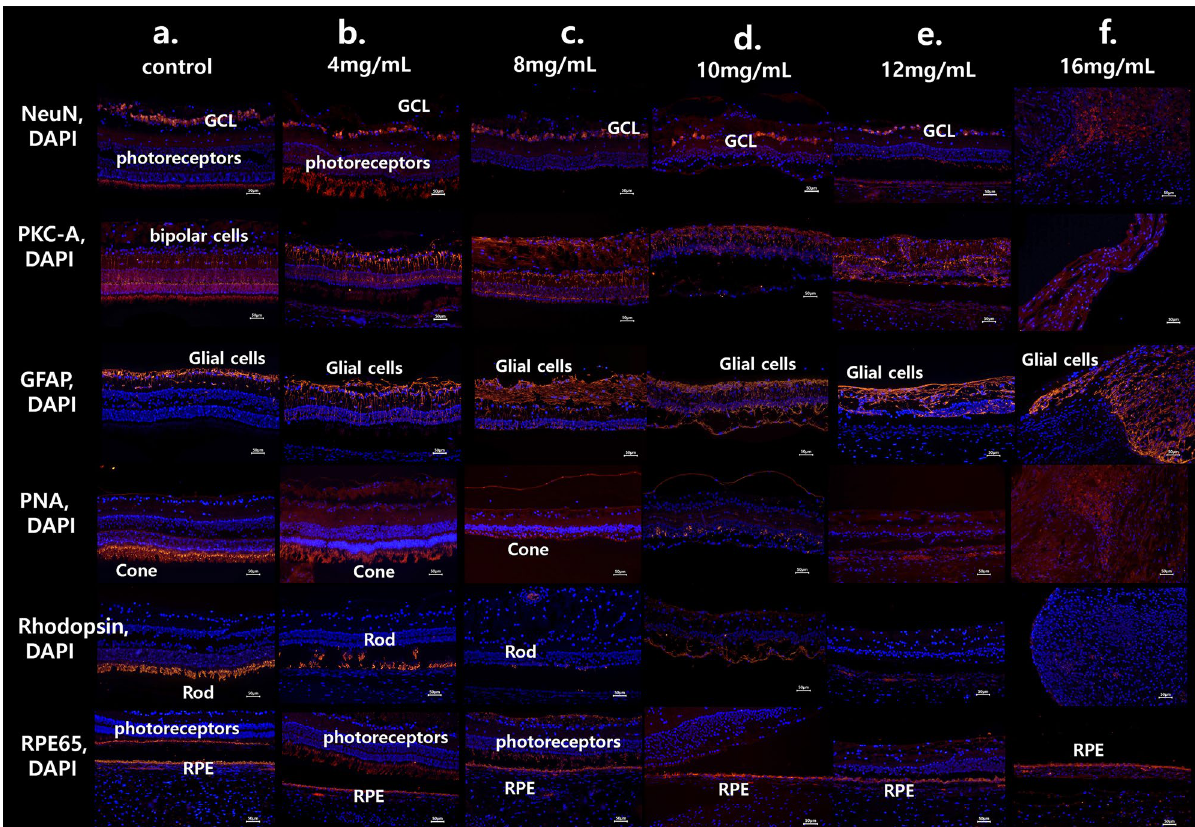
Figure 4. The immunohistochemistry findings of the retina in cases of 4 mg/mL, 8 mg/mL, 10 mg/mL, 12 mg/ mL, and 16 mg/mL MNU. ( a ) The normal immunohistochemistry of a control case. Rhodopsin staining and PNA staining showed well-stained rod and cone cells (each percentage of the stained layer = 12.86% and 13.51%). ( b ) Immunohistochemistry of the 4 mg/mL MNU case. NeuN stain showed intact ganglion cells and co-staining of photoreceptors. PKC-α staining showed intact bipolar cells, and GFAP staining showed nearly normal muller cells. Rhodopsin staining showed intact rod cells (the percentage of the stained layer = 10.03%), and PNA staining showed intact cone cells (the percentage of the stained layer = 12.44%). RPE65 staining showed intact RPE and co-staining of photoreceptors. c . Immunohistochemistry of the 8 mg/ mL MNU case. NeuN staining showed intact GCL. PKC-α staining showed nearly intact bipolar cells but co-staining of few photoreceptors. GFAP staining showed mildly increased stained cells. Rhodopsin staining and PNA staining showed few stains of rod and cone cells, respectively (each percentage of the stained layer = 0.23% and 3.22%). RPE65 showed nearly intact RPE cells with co-staining of a few photoreceptors. ( d ) Immunohistochemistry of the 10 mg/mL MNU case. NeuN and PKC-α stainings showed ganglion cells and bipolar cells, respectively. There was no co-staining of photoreceptors with NeuN staining. GFAP stain showed increased staining. Rhodopsin and PNA staining showed rarely stained rod and cone cells (each percentage of the stained layer = 0.43% and 2.11%).with co-staining of RPE cells. RPE 65 showed intact RPE cells. ( e ) Immunohistochemistry of the 12 mg/mL MNU case. NeuN and PKC-α stainings showed ganglion cells and bipolar cells, respectively. There was no co-staining of photoreceptors with NeuN staining. GFAP stain showed increased staining. Rhodopsin and PNA staining showed no stained rod and cone cells (each percentage of the stained layer = 0% and 0%) with co-staining of RPE cells. RPE 65 showed intact RPE cells. ( f